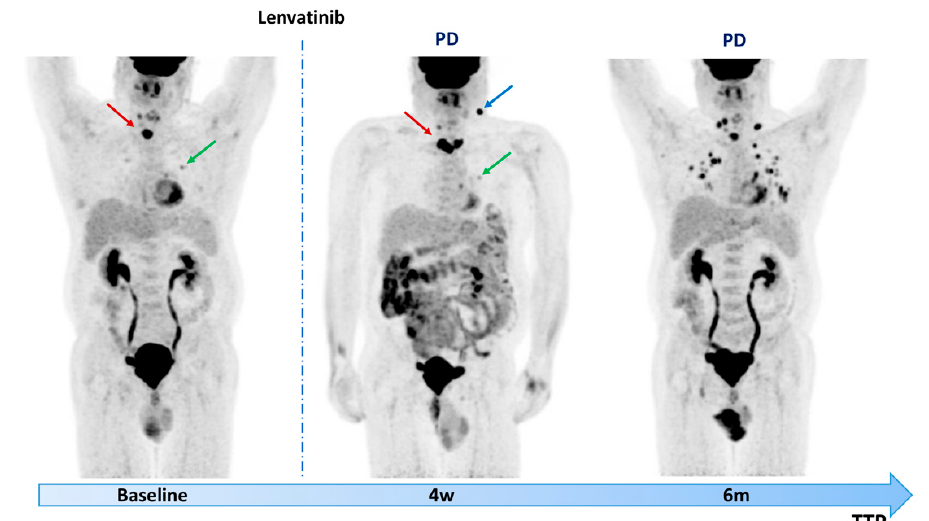
Figure 2. A 63-year-old man with metastatic RAI-R well-differentiated follicular cell thyroid cancer underwent [ 18 F]FDG PET/CT before starting lenvatinib therapy. Baseline PET showed an intense FDG uptake in the paratracheal region, corresponding to locoregional disease and moderate uptake in the bilateral pulmonary field. The patient then underwent reevaluation after 28 days from the beginning of MKI therapy, which showed disease progression with the appearance of a metastatic submandibular lymph node. After surgical lymph node resection, the patient continued lenvatinib therapy with disease progression 6 months later. PD = progression disease; w = week; m = month; TTP = time to tumor progression; RAI-R = refractory radioactive iodine; [ 18 F]FDG PET/CT = 2-deoxy-2-[ 18 F]fluoro-D-glucose positron emission tomography/computed tomography; MKIs = multi-kinase inhibitors.